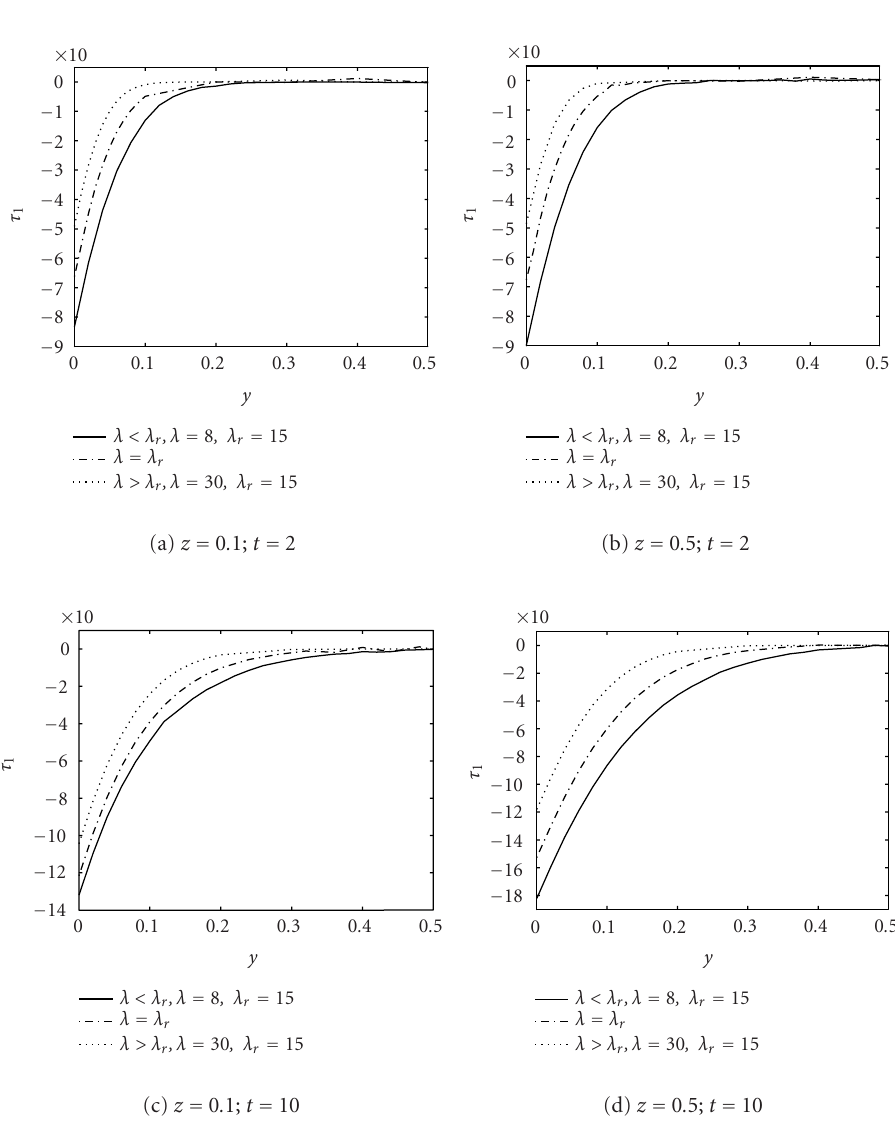
the figures that the second-grade fluid is the swiftest while the Maxwell fluid is the slowest, for the same initial and boundary conditions. For large values of t , the non-Newtonian e ff ects become weak and the profiles for the velocity fields for the four fluids as well as those for the associated stresses are nearly